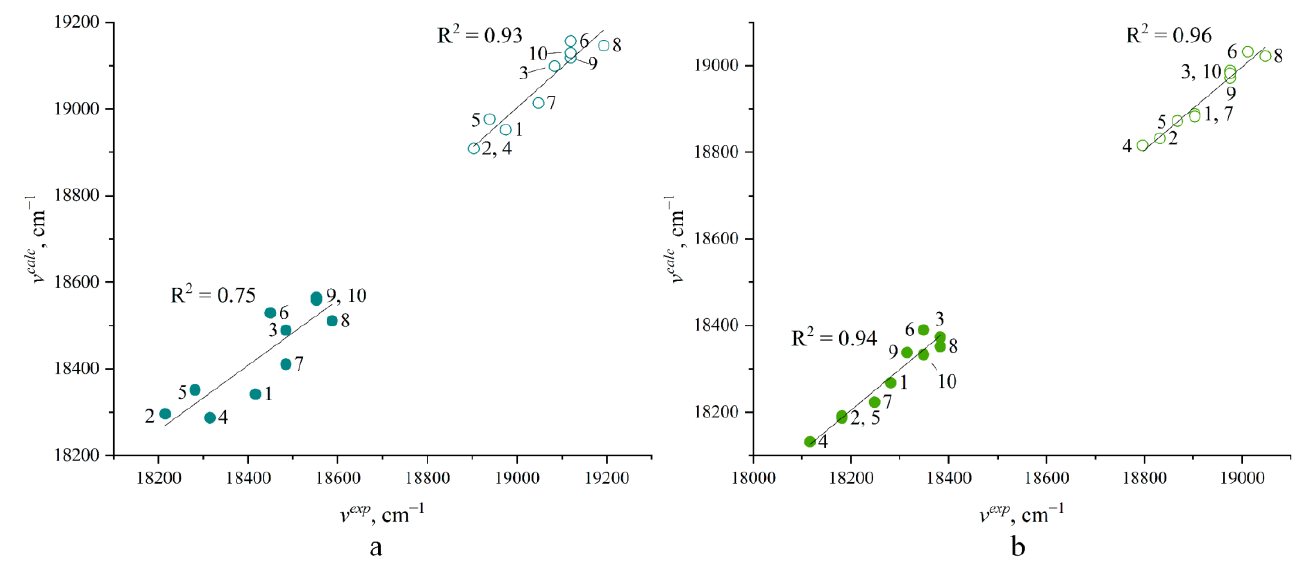
Figure 2. Relationships between experimental and calculated maximum absorption ν abs (max) (open circle) and emission ν em (max) (full circle) wavenumbers of COOH-Ph-BODIPY ( a ) and NHS-Ph- BODIPY ( b ) obtained by multiple linear regression analysis according to Equation (5) in which y 0 , a − d are regression coefficients (numbers refer to organic solvents in Table 1).